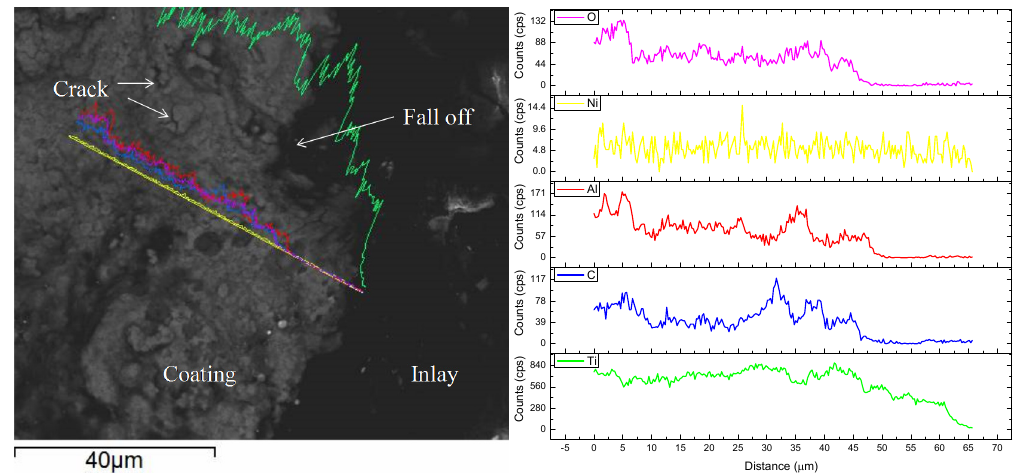
Figure 10. SEM and line scanning spectra of the cross section of the coating surface after the immersion test.